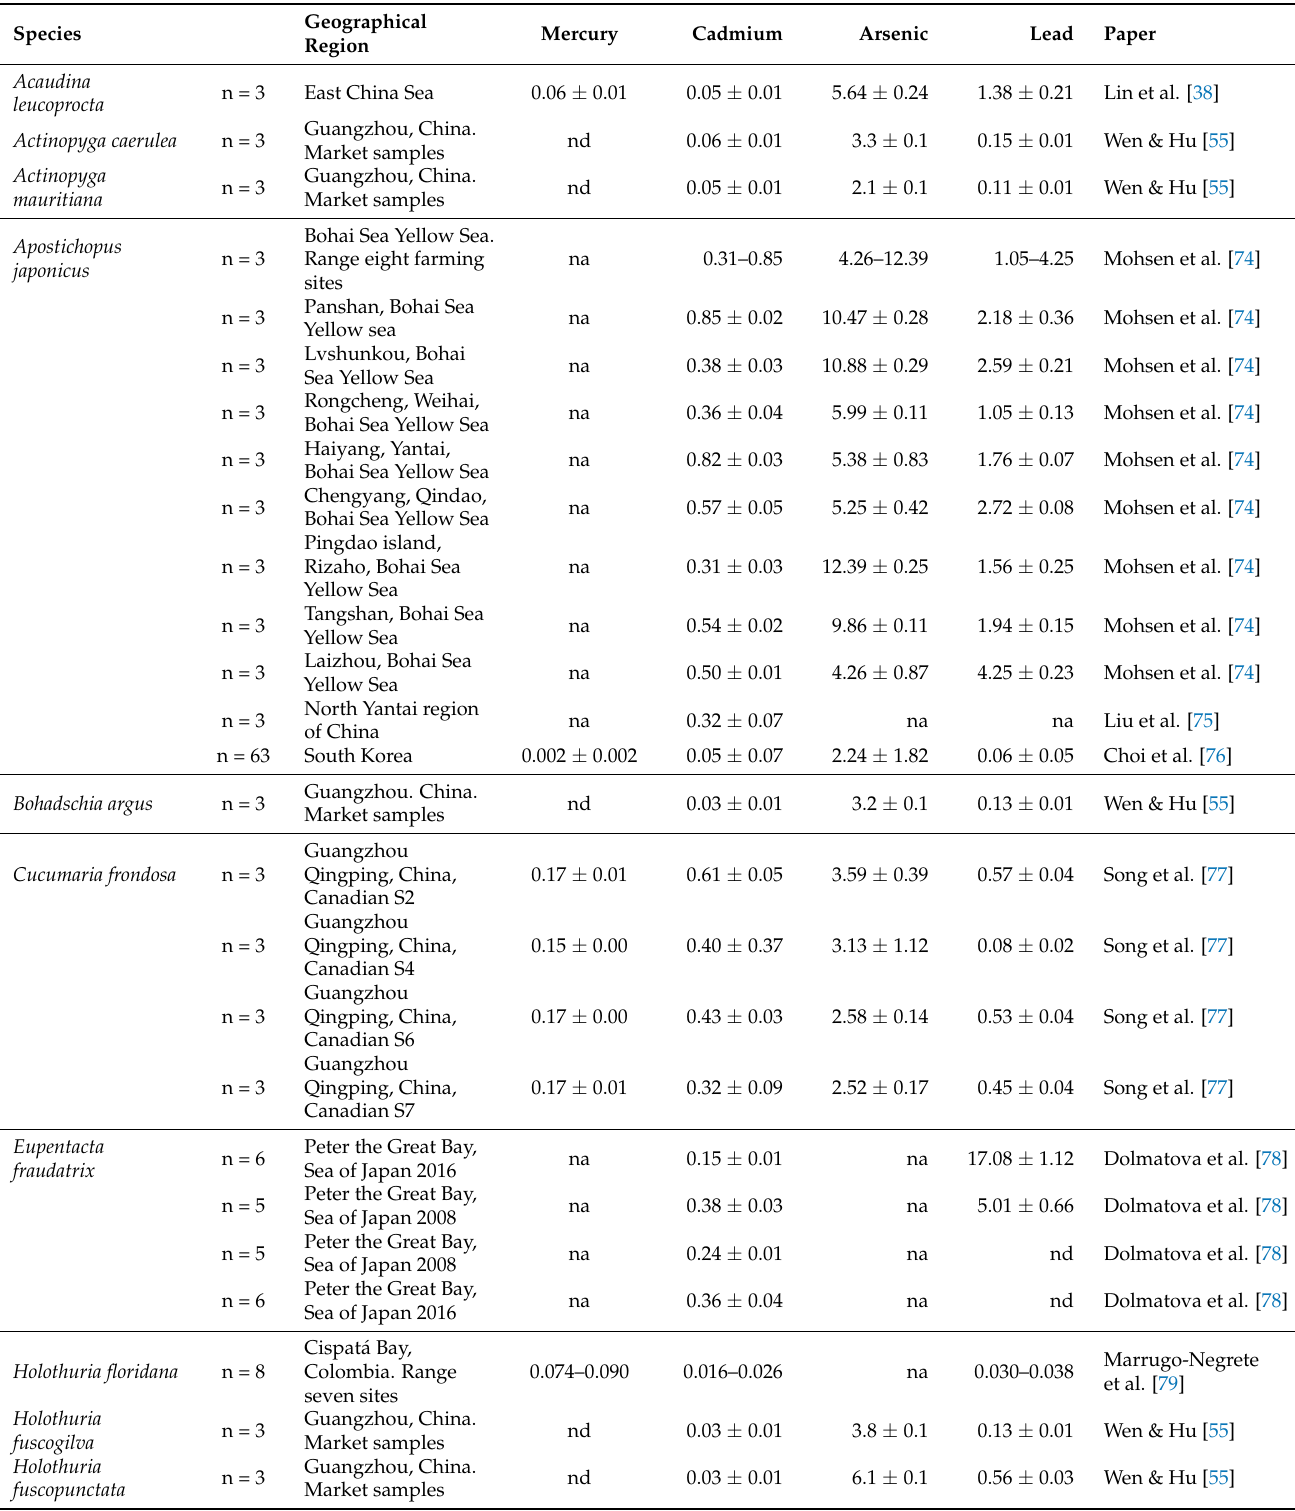
Table 2. Species, number of samples n, geographical region of sampling, concentration of Mercury (Hg), Cadmium (Cd), Arsenic (As) and Lead (Pb) given as mean ± standard deviation (SD) mg/kg dry weight (dw) in body wall or comparable tissue of sea